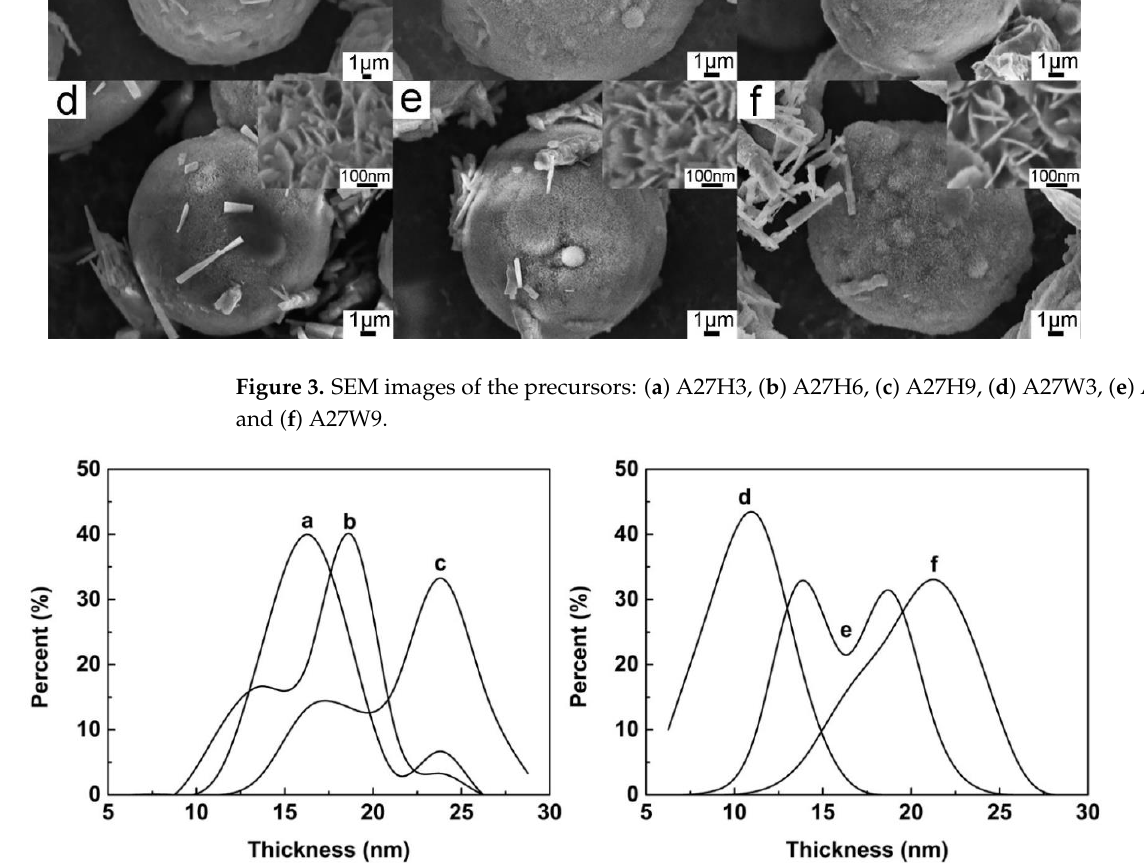
Figure 4. The thickness distribution of the Al(OH) 3 nanosheets: ( a ) A27H3, ( b ) A27H6, ( c ) A27H9, ( d ) A27W3, ( e ) A27W6, and ( f ) A27W9.